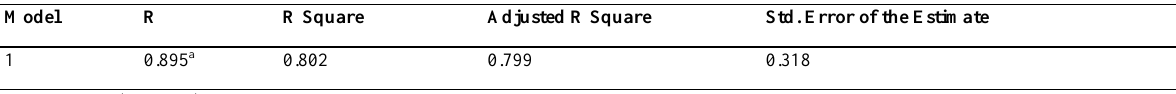
Table 3: Regression Model Summary table of Contingent capital and Performance of Hydroelectric Energy Projects Model